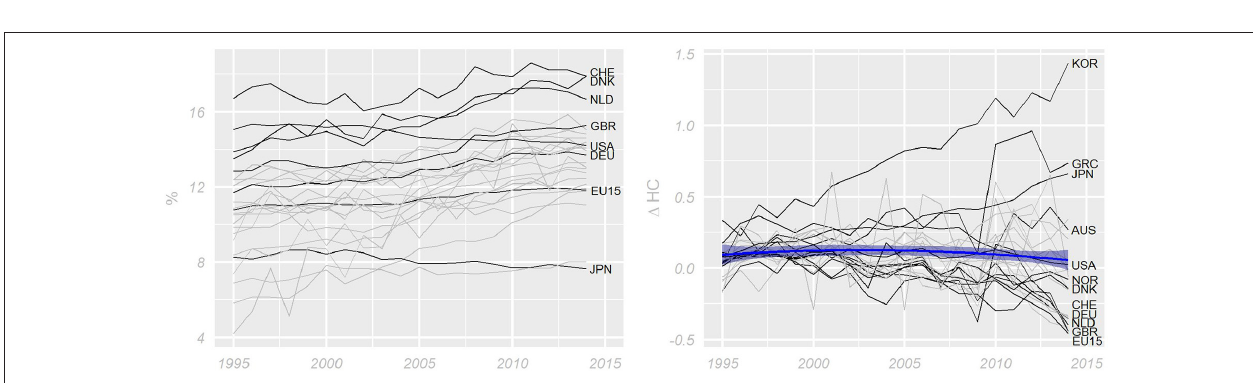
FIGURE 7 | (Left panel) National shares of highly cited publications; (Right panel) according changes due to the increase in Chinese